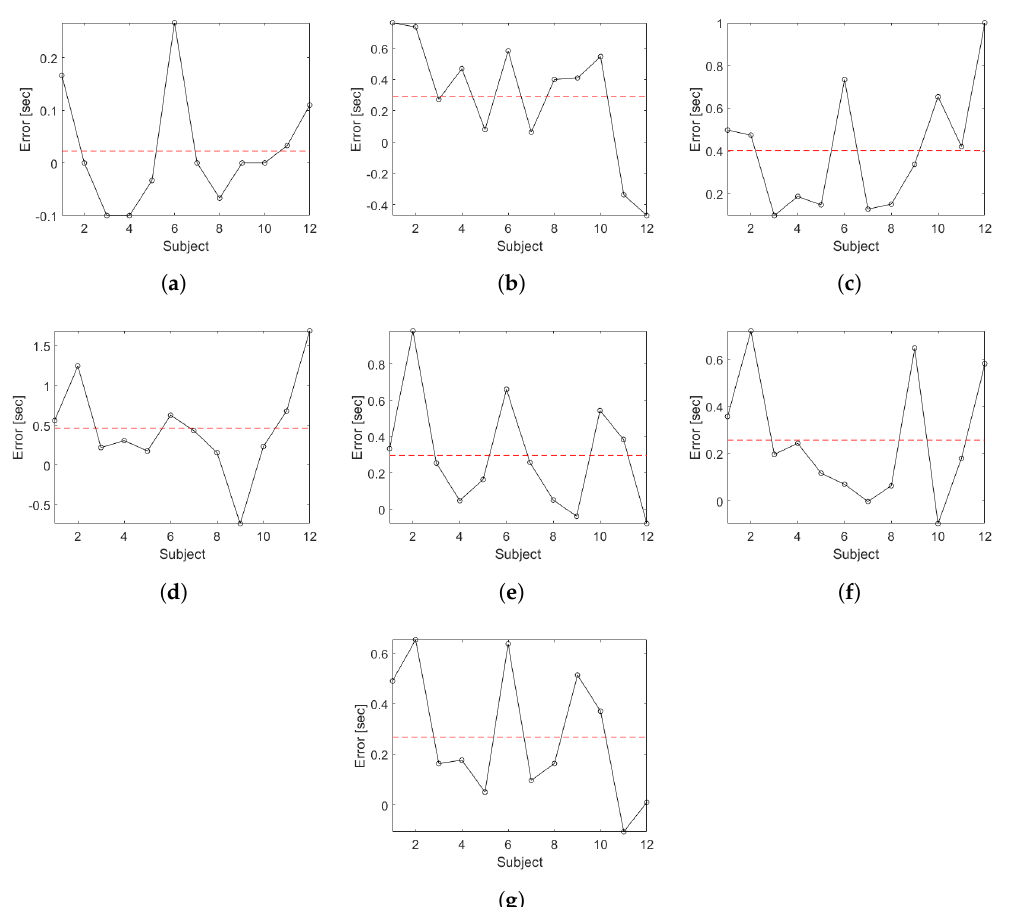
Figure 16. Error plots for the segmentation time for each sub task of the TU & Go test in the older adults group. The segmented lines correspond to the mean error. ( a ) end of the standing/start of the first walk; ( b ) end of the first walk/start of the 3-m turn; ( c ) end of the 3-m turn/start of the second walk; ( d ) end of the second walk/start of the pre-sitting turn; ( e ) end of the pre-sitting turn; ( f ) start of the sitting; ( g ) end of the